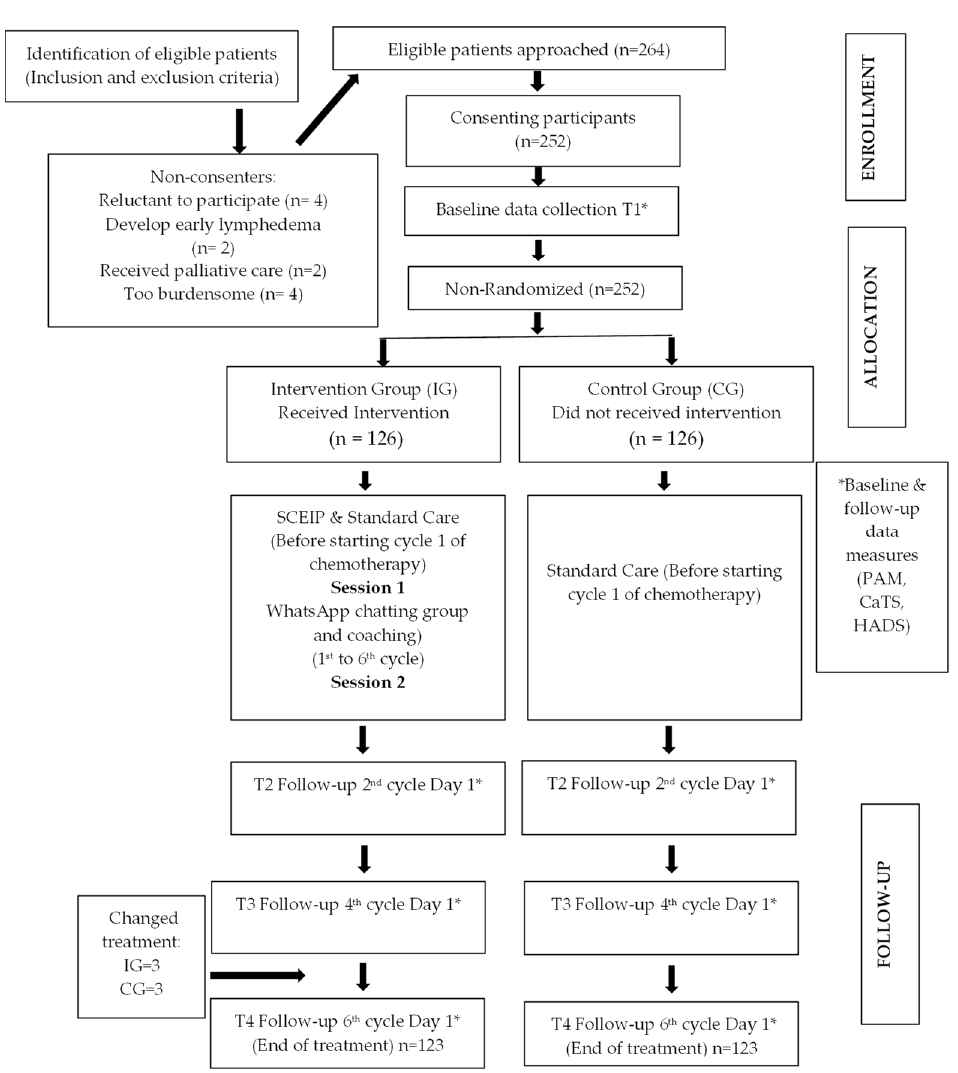
Figure 1. Consort diagram. T, time; Baseline & follow-up data measures, CaTS, Cancer Treatment Survey; HADS, Hospital Anxiety Depression Scale; PAM, Patient Activation Measure.